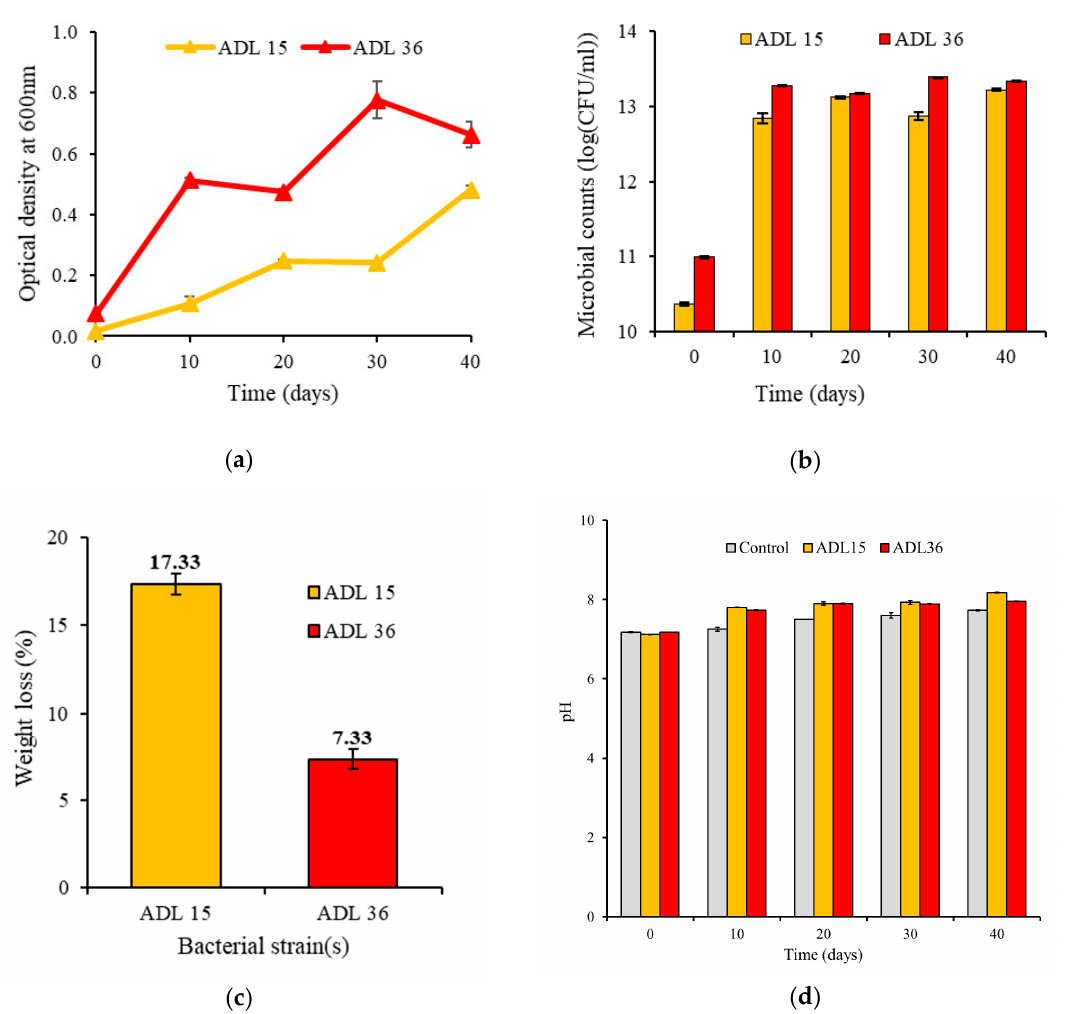
Figure 1. Changes in cultures of the Antarctic bacteria Pseudomonas sp. ADL15 and Rhodococcus sp. ADL36 during 40 days of incubation in Bushnell Haas (BH) media infused with polypropylene (PP) microplastics: ( a ) optical density, ( b ) microbial counts, ( c ) relative weight loss of PP microplastics, and ( d ) pH of the media. Data represent mean ± SD, n = 3.